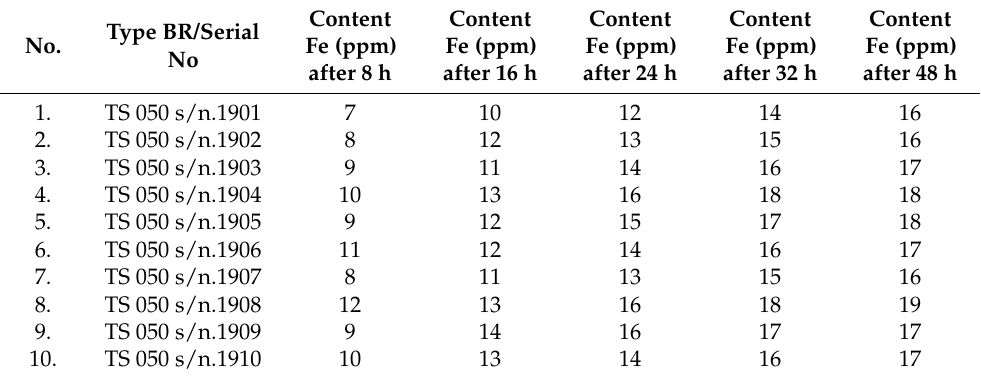
Table 3. Values of solid abrasive particles during 48 h of the BR TS 050 trial run.